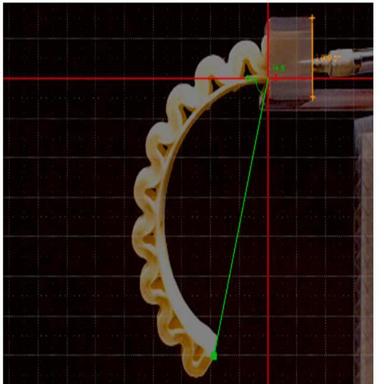
Displacement analysis (15 psi).